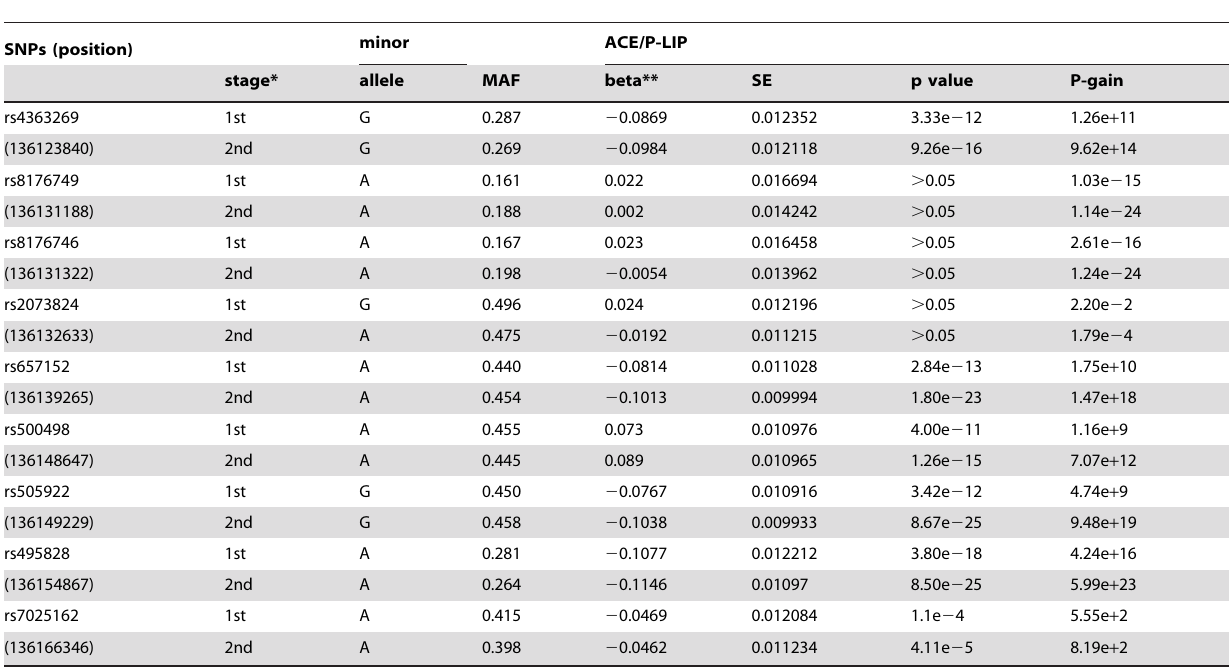
Table 3. Antagonistic pleiotropism of ABO gene in 9q32 with ACE/P-LIP in Takahata and Yamagata populations.